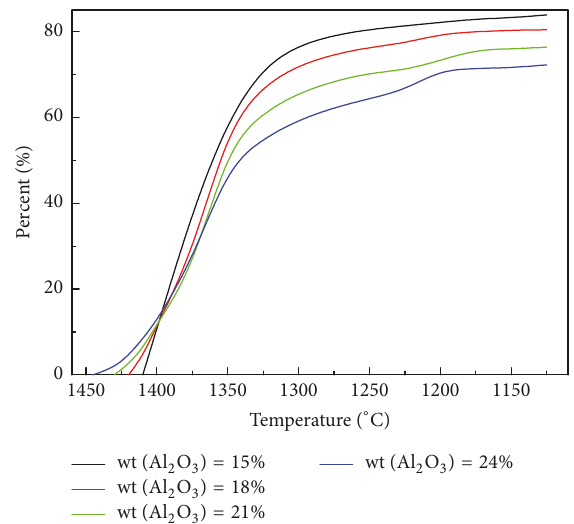
Figure 9: Crystallization amount of the melilitite